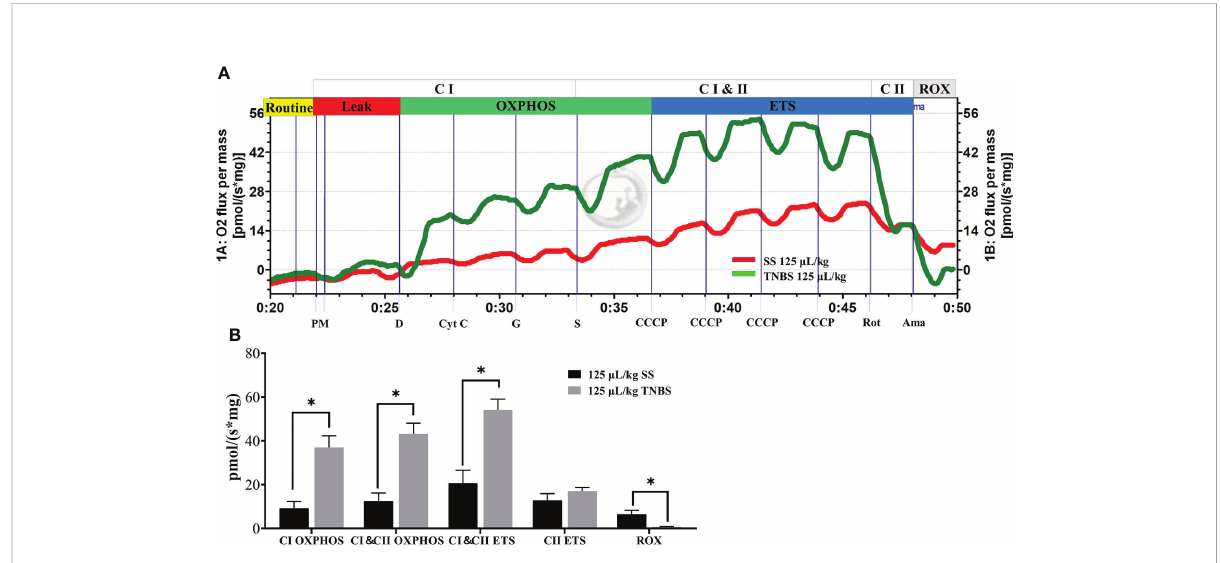
FIGURE 6 The TNBS enhanced the respiratory of mitochondria in liver. (A) Representative effects of TNBS on mitochondrial function. The oxygen fl ux at different respiration states is obtained by introducing speci fi c substrates and inhibitors to the samples. Red line, oxygen consumption in response to the application of substrates for complex I (CI) and II (CII) with 125 m L/kg SS. Green line, with 125 m L/kg TNBS. (B) Summarized data for oxygen consumption in the liver as measured via Oxygraph-2k high-resolution respirometry. P value was calculated by Student ’ s t tests. All data are expressed as mean ± S.E.M. (N = 7). * P < 0.05, compared with PBS